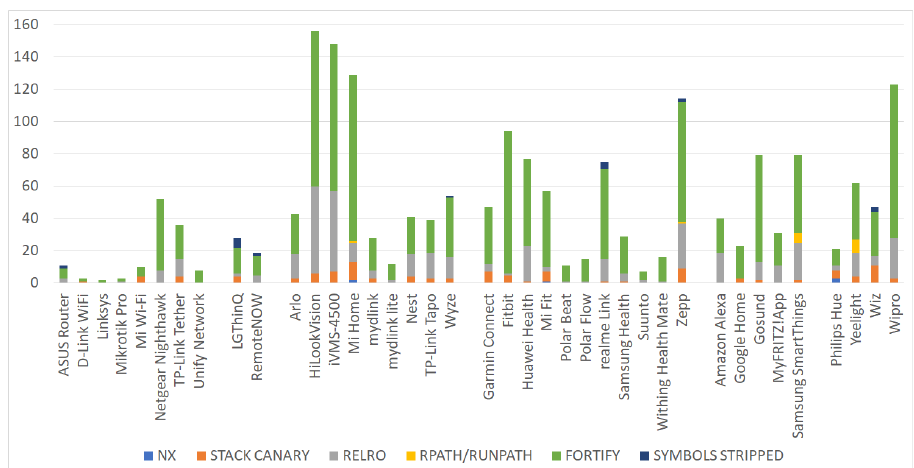
Figure 4. Number of identified shared library issues per